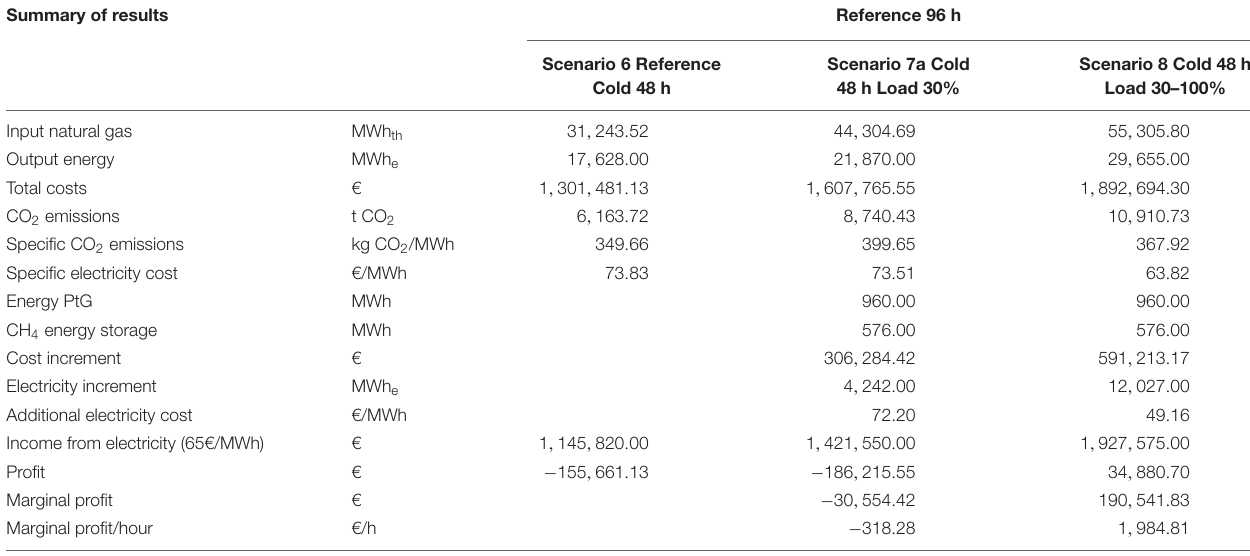
TABLE 8 | Comparison of different operation modes during the period of cold start-up. Summary of results